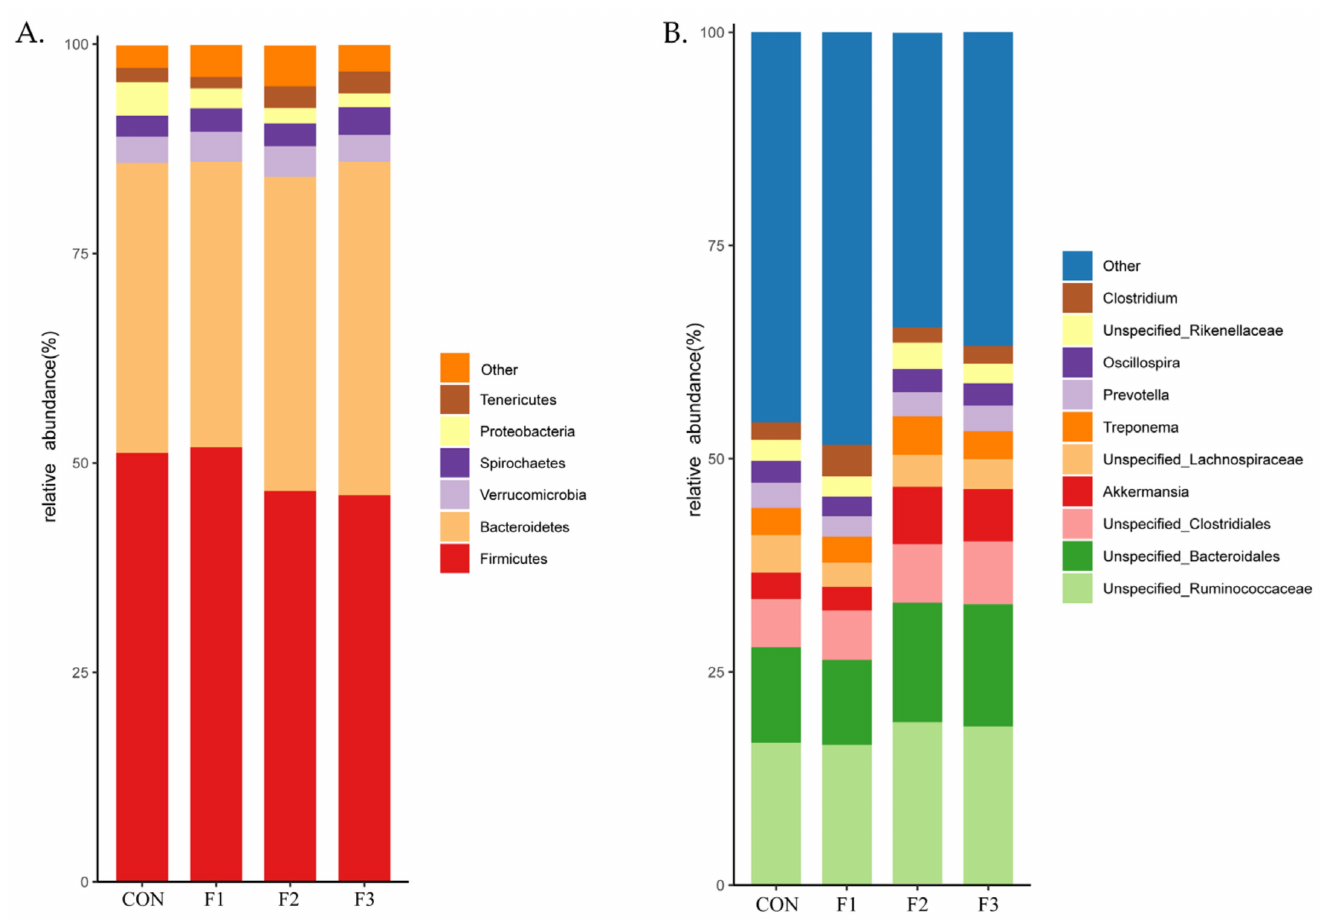
Figure 7. Bacterial composition at phylum ( A ) and genus ( B ) level in cecal content of goat kids among four dietary treatments. CON, basal diet; F1, basal diet + 0.1% fucoidan; F2, basal diet + 0.3% fucoidan; F3, basal diet + 0.5%